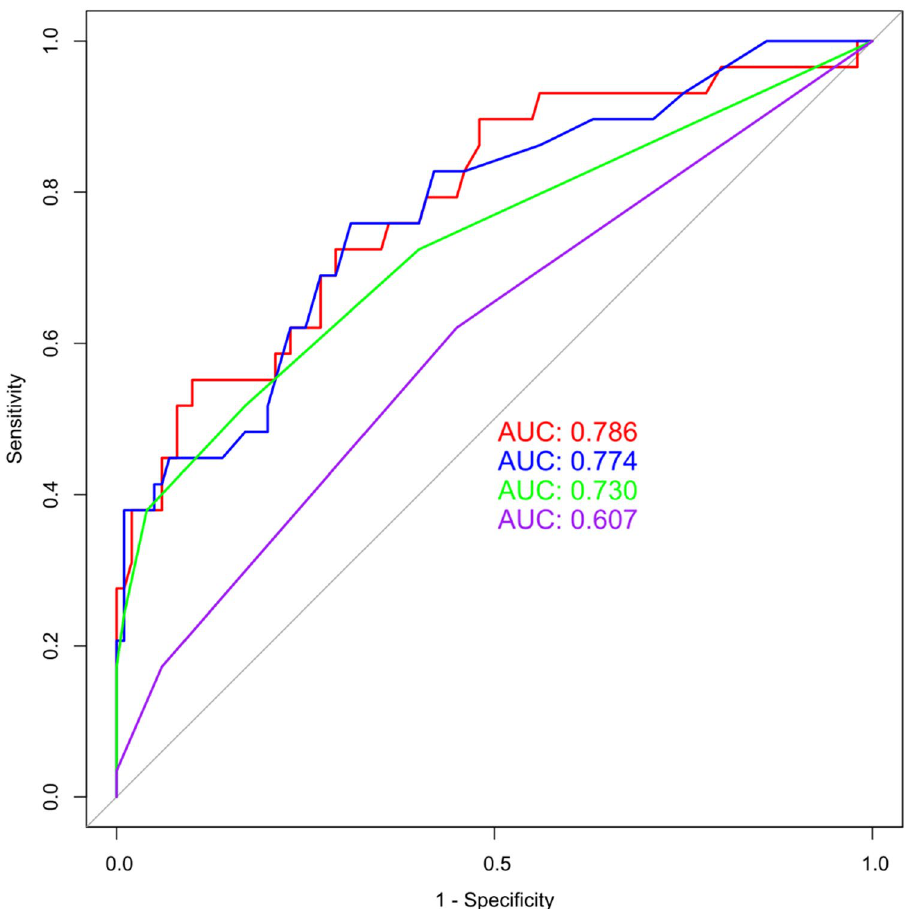
Figure 4. ROC curve of MMSE’s prediction model. (red: the optimal combination of variables; blue: the top ten features of RDA; green: the top ten features of MMSE RF analysis; purple: the top ten features of MoCA RF analysis).